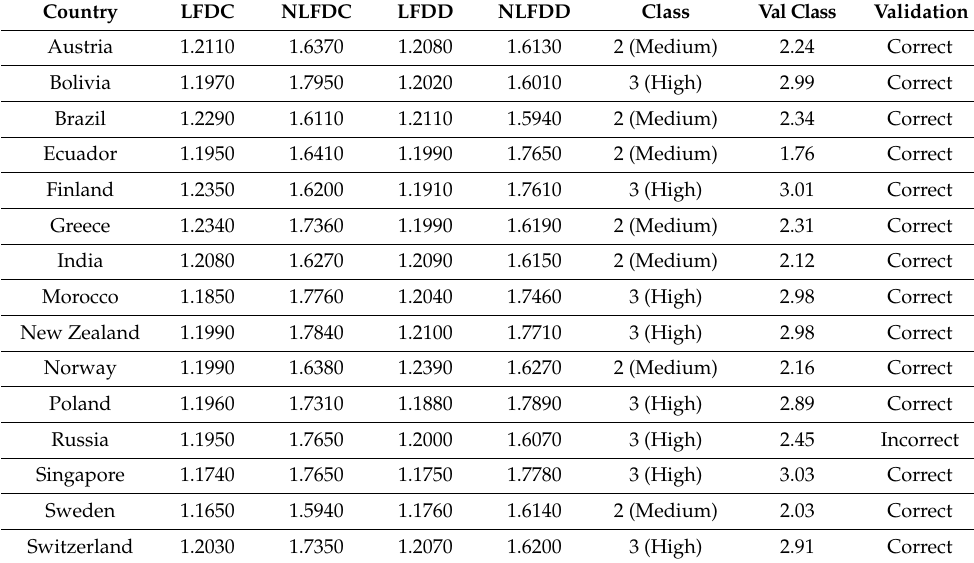
Table 3. Validation of the Fuzzy Fractal Classification Method with 15 countries.